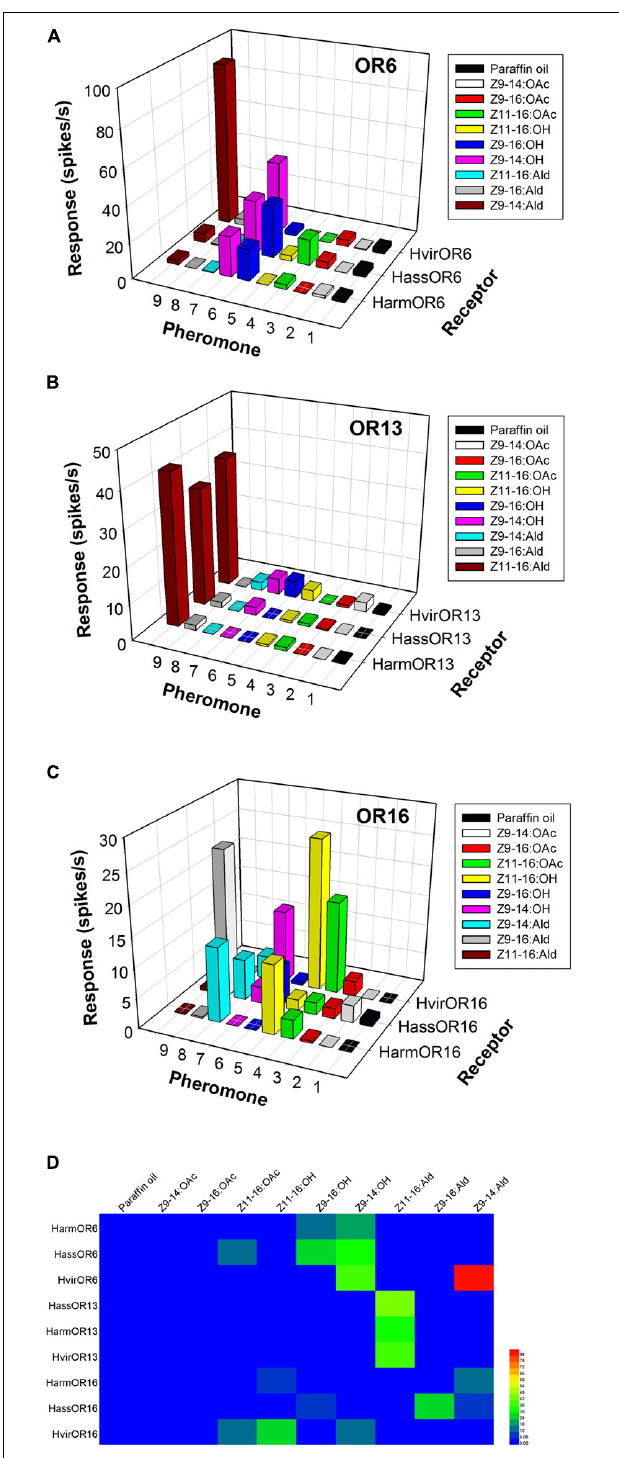
FIGURE 3 | Odor coding of pheromone receptors (PRs) from three closely related species. (A) Responses of OR6-expressing neurons in at1 sensilla of transgenic flies. (B) Responses of OR13-expressing neurons in at1 sensilla of transgenic flies. (C) Responses of OR16-expressing neurons in at1 sensilla of transgenic flies. (D) Heatmap of response spectra of PR-expressing neurons in at1 sensilla of transgenic flies.